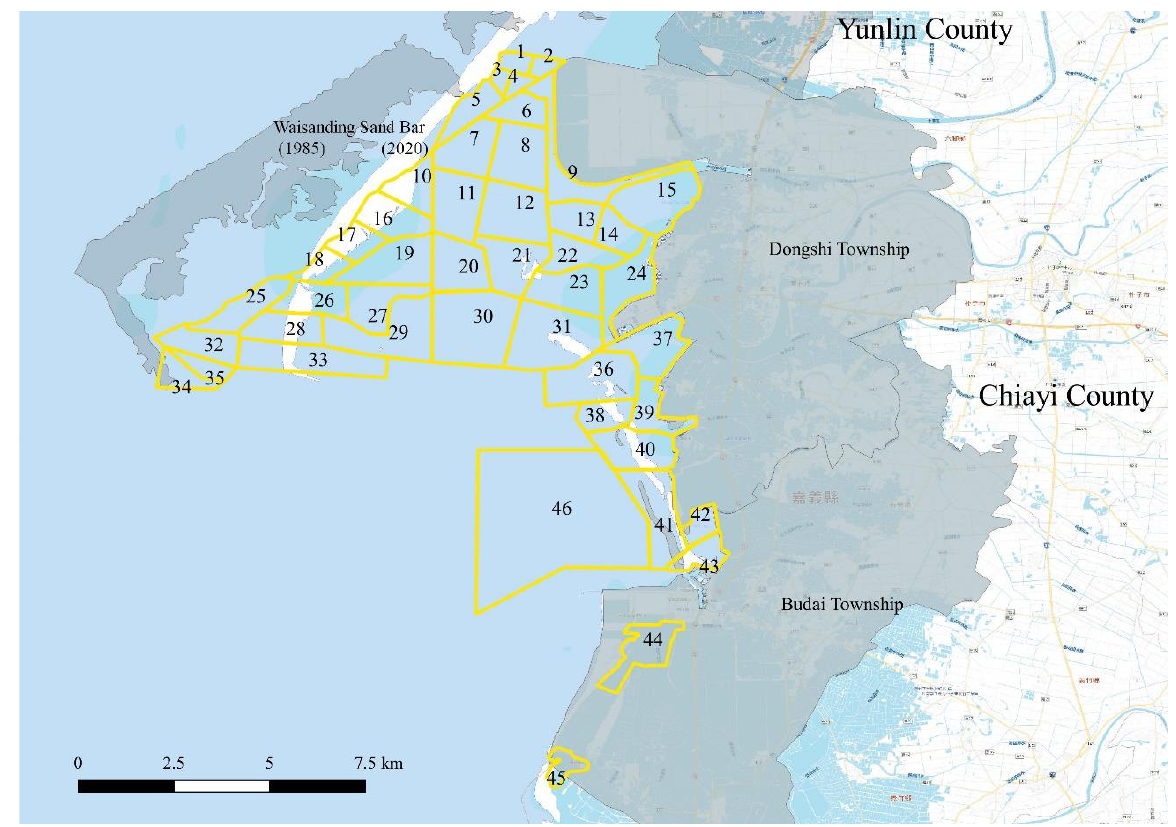
Figure 2. The evolution of the Waisanding Sandbar near Chiayi and an overview of the demarcated zones for oyster farming.